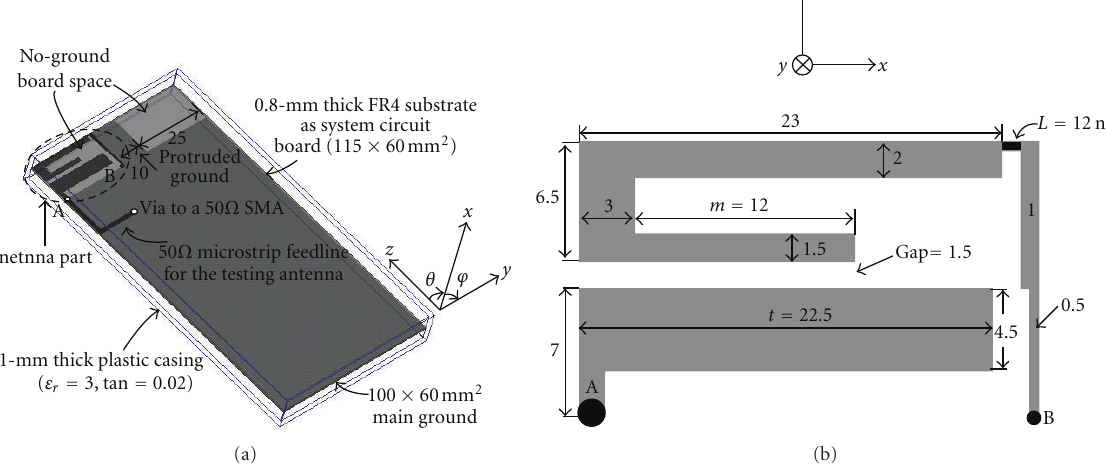
Figure 1: (a) Overall structure of the proposed antenna. (b) Dimensions of the proposed antenna (unit: mm). foot print of the system circuit plane. A protruded ground